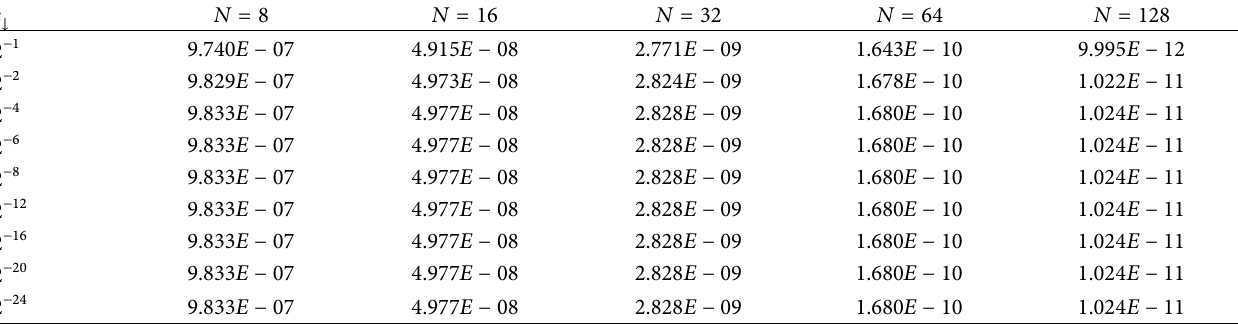
푁 , for the solution 휀,2 𝐷